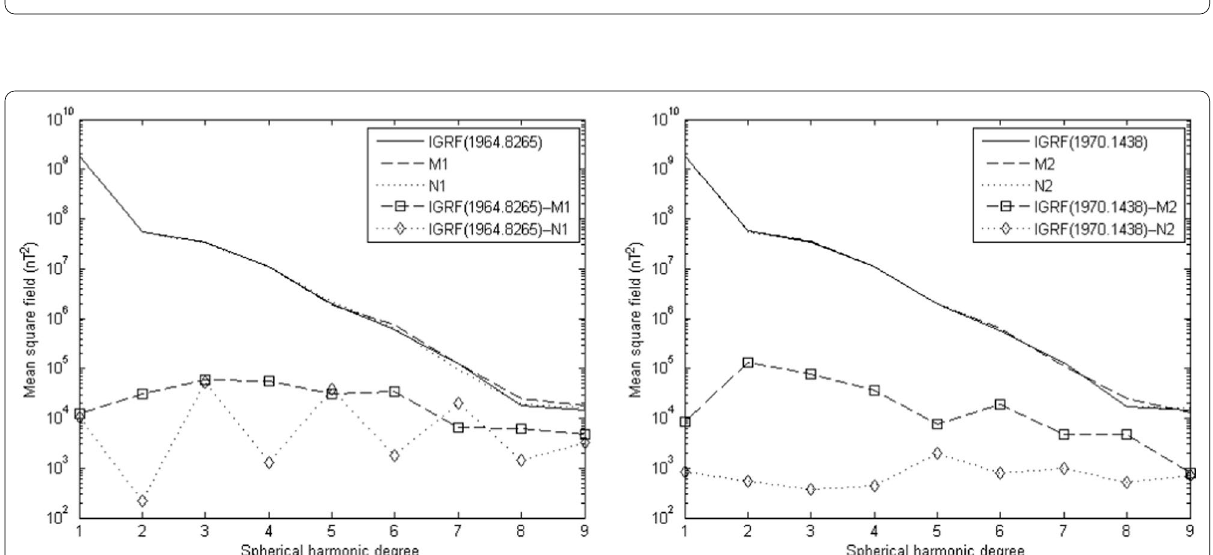
Fig. 10 Power spectra of models IGRF, M-1,2 and N-1,2 and the differences between IGRF and M-1,2, IGRF and N-1,2 at epochs 1964.826 (October 29, 1964) ( a ) and 1970.144 (February 22, 1970) ( b ), respectively, at Earth mean radius (6371.2